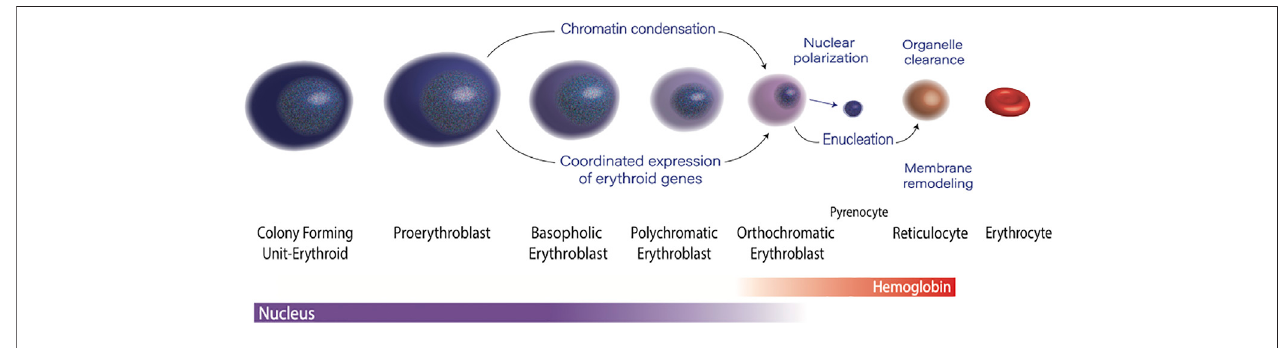
FIGURE 1 | Overview of